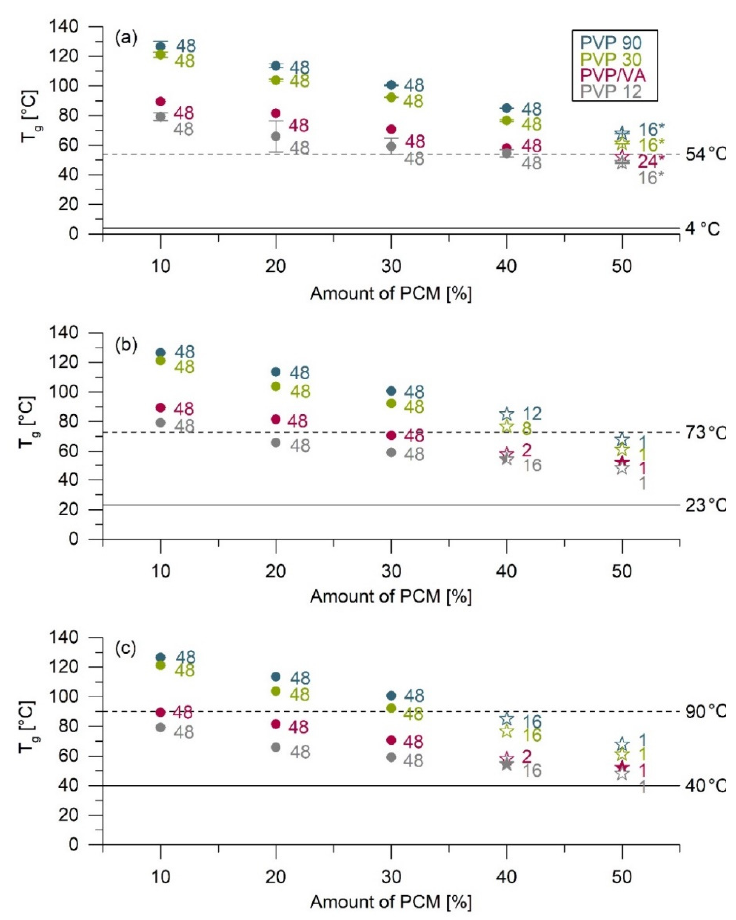
Figure 1. Summary of the glass transition temperature (T g ) values of ASDs and the stability results obtained by powder X-ray diffraction (XRD) measurement. The stability test was conducted under three different storage conditions: ( a ) storage at 4 °C without humidity control, ( b ) storage at 23 °C/75% RH, and ( c ) storage at 40 °C/75% RH. T g : The T g were determined directly after the production of ASDs and are reported as the average ± SD, n = 1–2. For clarity, the T g error bars are shown in Figure 1a only. The solid lines indicate the storage temperature, and the dashed lines indicate the temperature 50 °C above the storage temperature. XRD: The XRD results are shown as circles and stars. Circles represent the amorphous state; the numbers indicate the weeks in which the ASDs were still amorphous. Stars represent three types of recrystallization. Open stars show recrystallization in polymorphic form I. Closed stars show recrystallization in polymorphic form II. Semi-closed stars represent recrystallisation in both form I and form II. The numbers indicate the weeks in which recrystallization was detected in the XRD measurements. Numbers with *: initial XRD analysis was carried out 16 or 24 weeks after preparation. Recrystallization may therefore have occurred